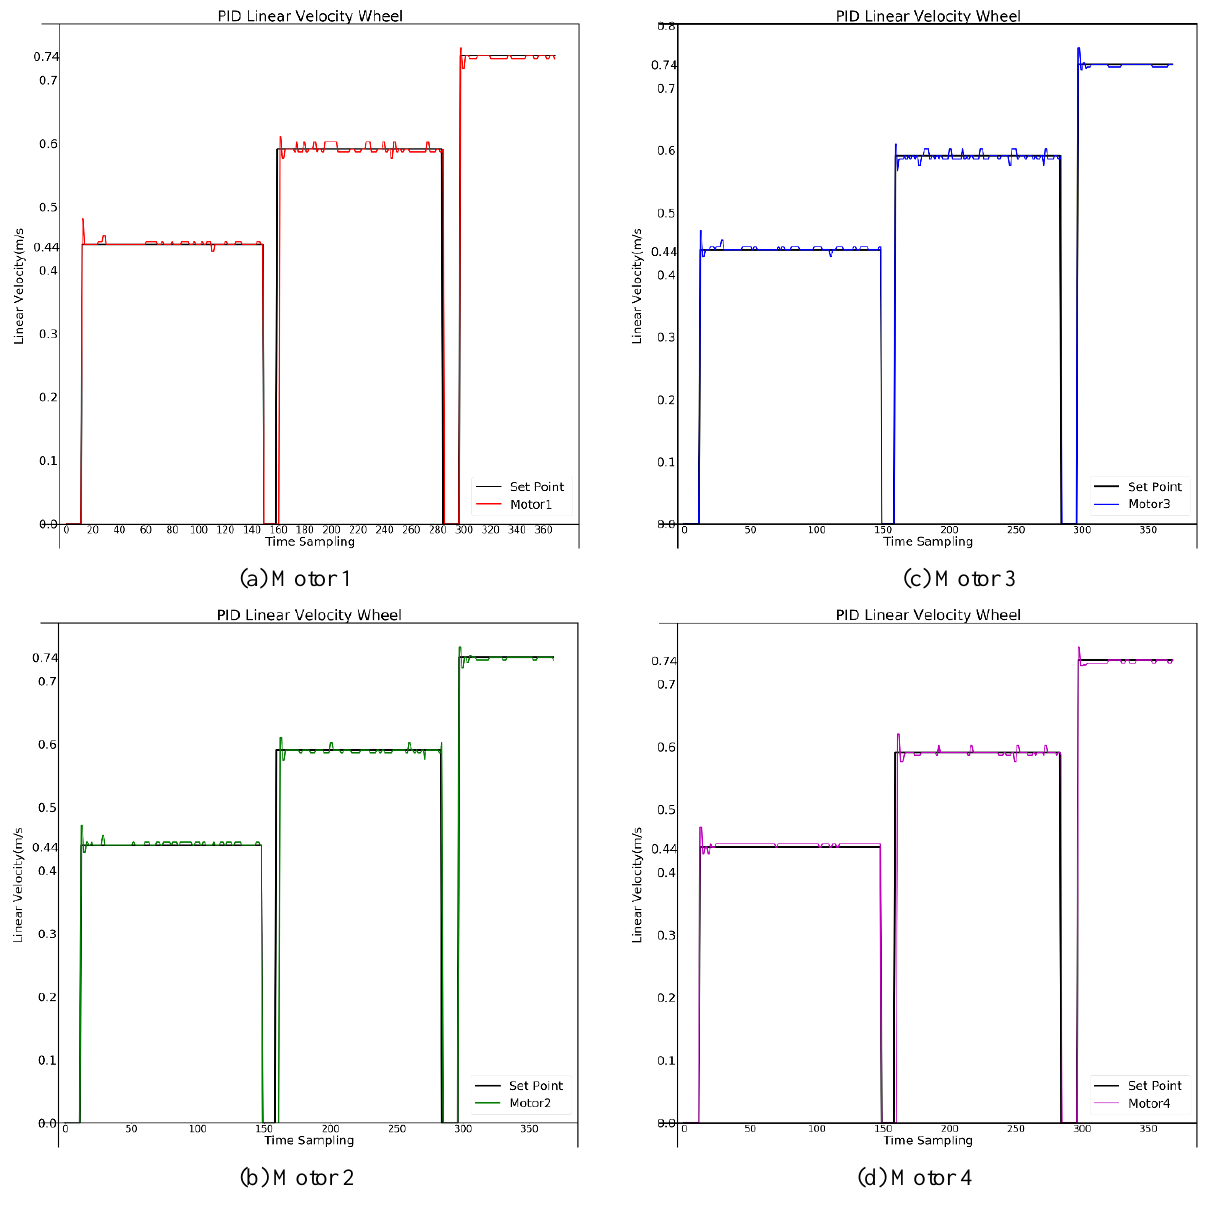
Figure 11. Response of Motor Speed Control to Various Set-points without Acceleration